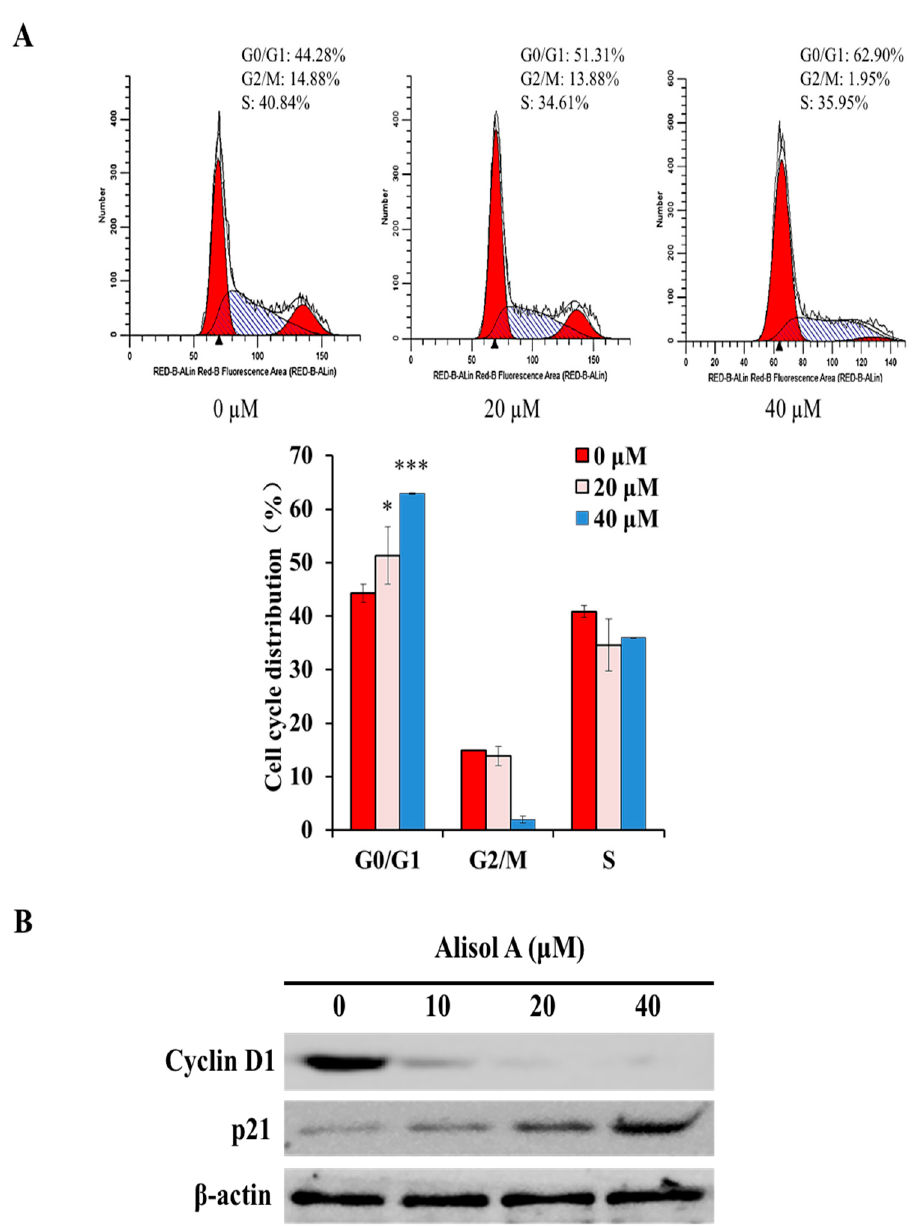
Figure 5. E ff ects of alisol A on cell cycle in MDA-MB-231 cells. ( A ) MDA-MB-231 cells were treated with alisol A for 24 h, fixed in 70% ethanol at 4 ◦ C overnight, and stained with propidium iodide (PI). Cell cycle distribution was assessed by flow cytometry. Quantified histograms display the e ff ects of alisol A on cell cycle distribution. ( B ) The expression of cell cycle-related proteins, Cyclin D1 and p21 in MDA-MB-231 cells were analyzed by Western blotting. Data are presented as the mean ± S.D of three independent experiments. * p < 0.05, *** p < 0.001.